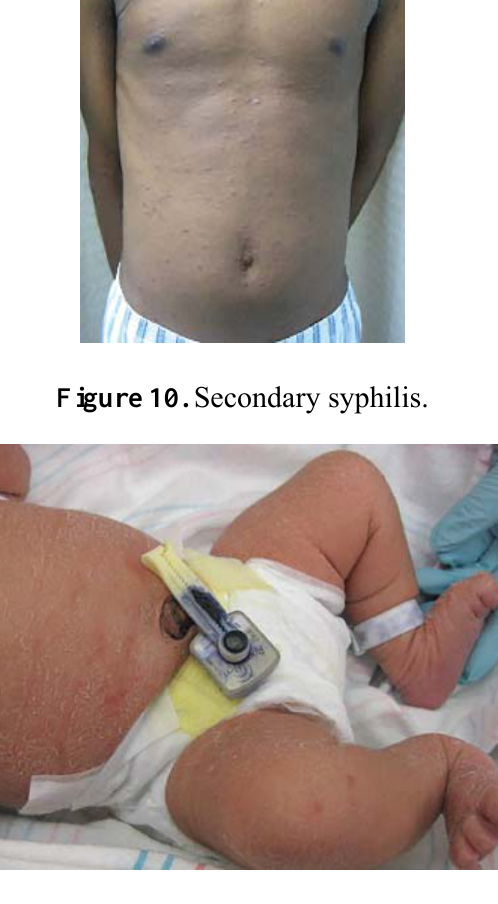
Figure 11. Congenital